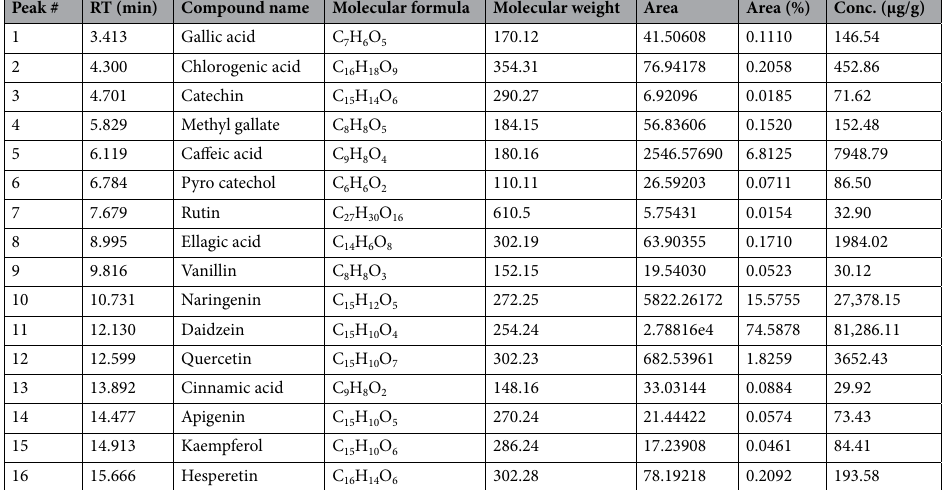
Table 2. HPLC analysis of phenolics and flavonoids in the ethyl acetate crude extract of Paecilomyces sp. (AUMC 15,510).